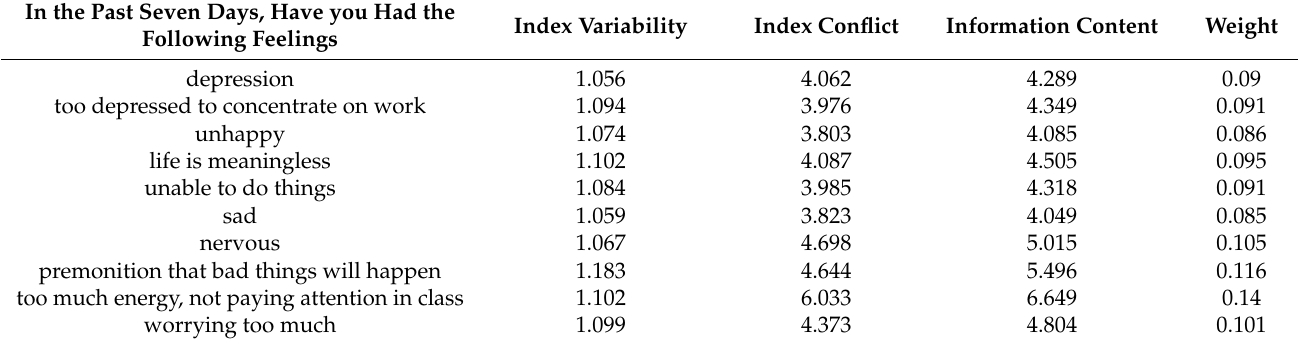
Table 1. Entropy weight